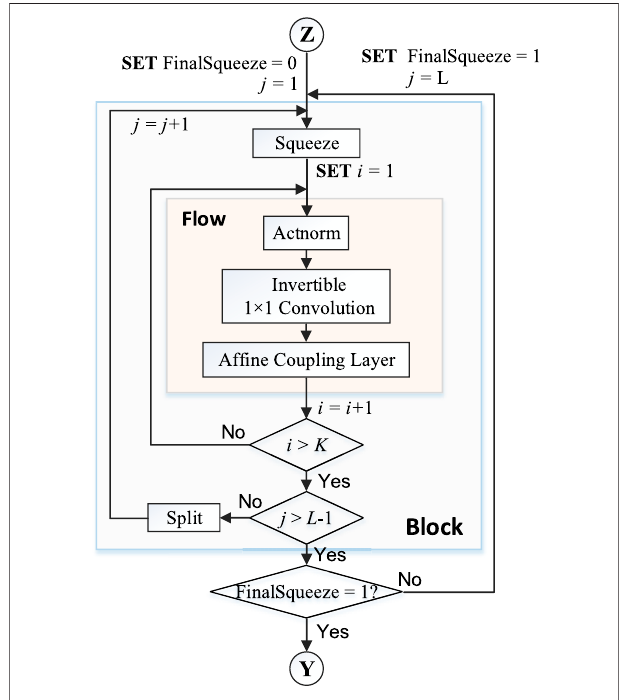
FIGURE4| ArchitectureofGlow.TheFlowisintroducedby(Kingmaand Dhariwal, 2018) to the multi-scale architecture proposed in (Dinh et al., 2016).